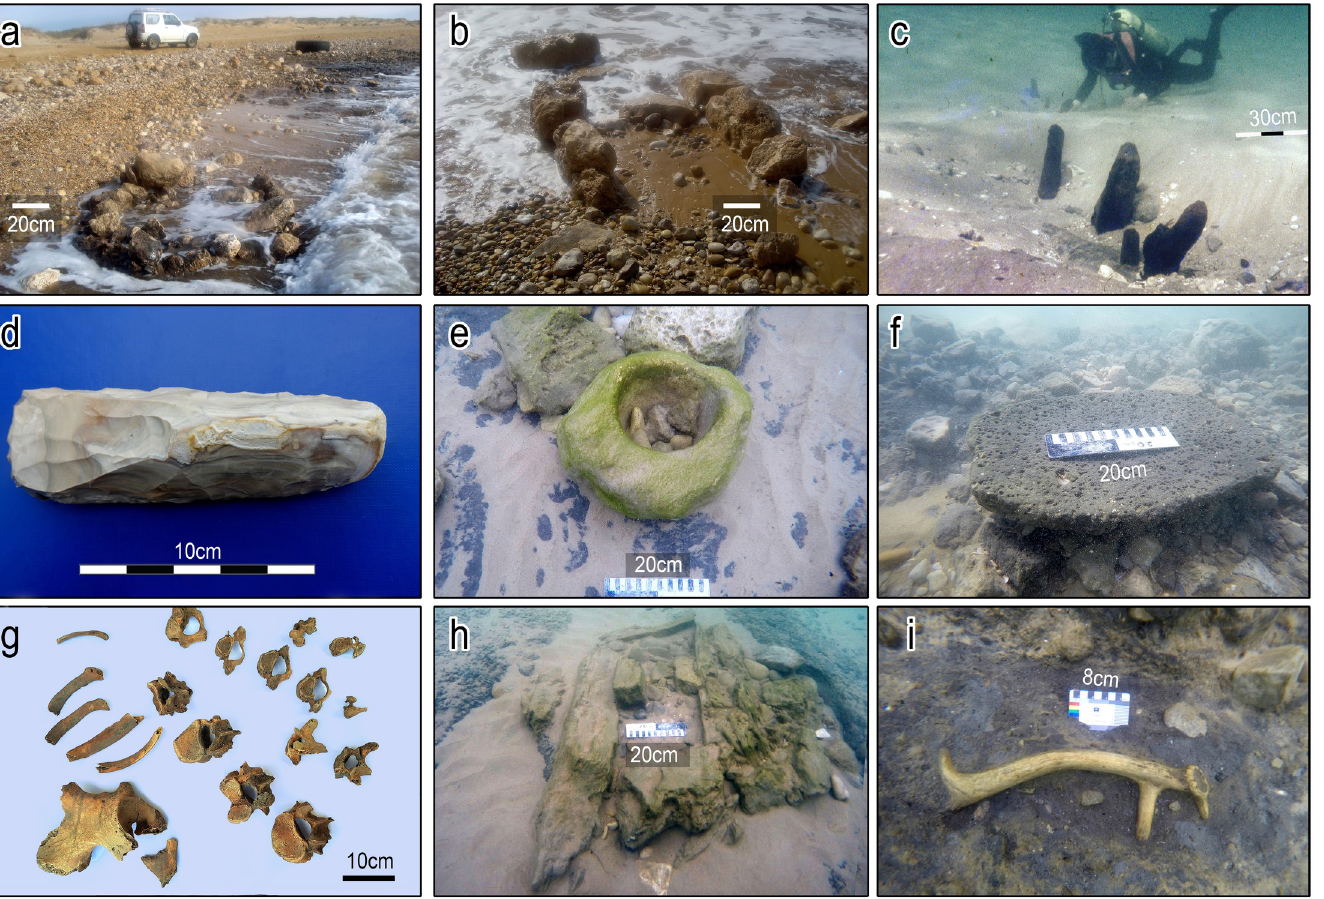
Fig 3. Photographs of finds from the Tel Hreiz settlement. (a-b) exposure of stone-built features in shallow water. (c) wooden posts dug into the seabed. (d) bifacial flint adze. (e) in situ stone bowl made of sandstone. (f) in situ basalt grounding stone (scale = 20cm); (g) burial 1. (h) suspected stone-built cist grave - view from the east (scale = 20cm). (i) in situ antler of Mesopotamian fallow deer, Dama dama mesopotamica . (All photographs by E. Galili with the exception of Fig 3G by V. Eshed).